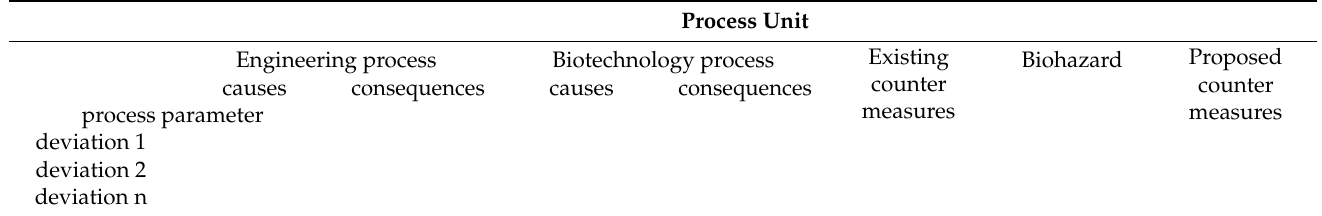
Table 2. BioHazOp worksheet